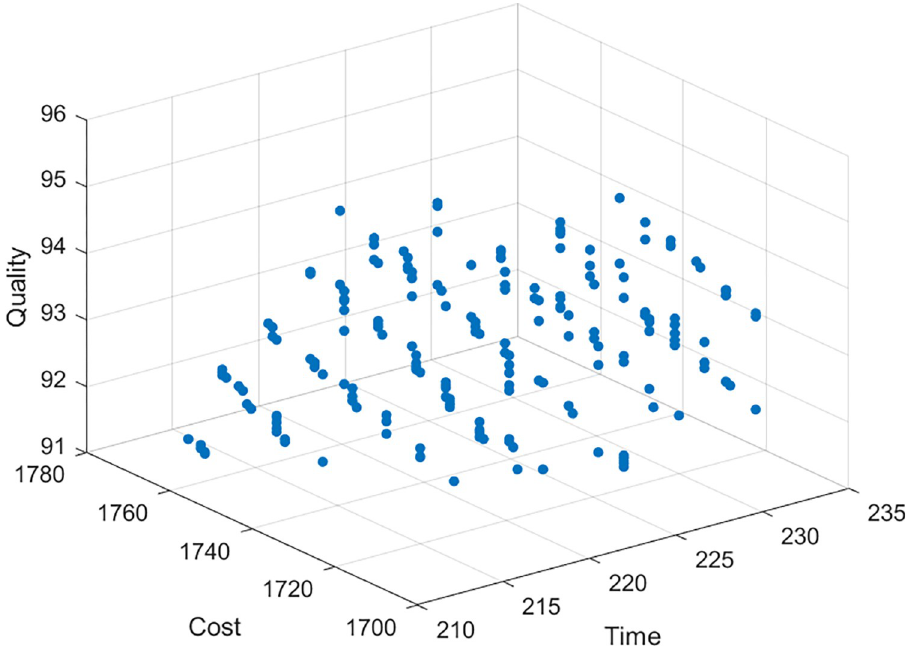
Fig 12. Time–cost–quality tradeoff Pareto front using MOIWCA.